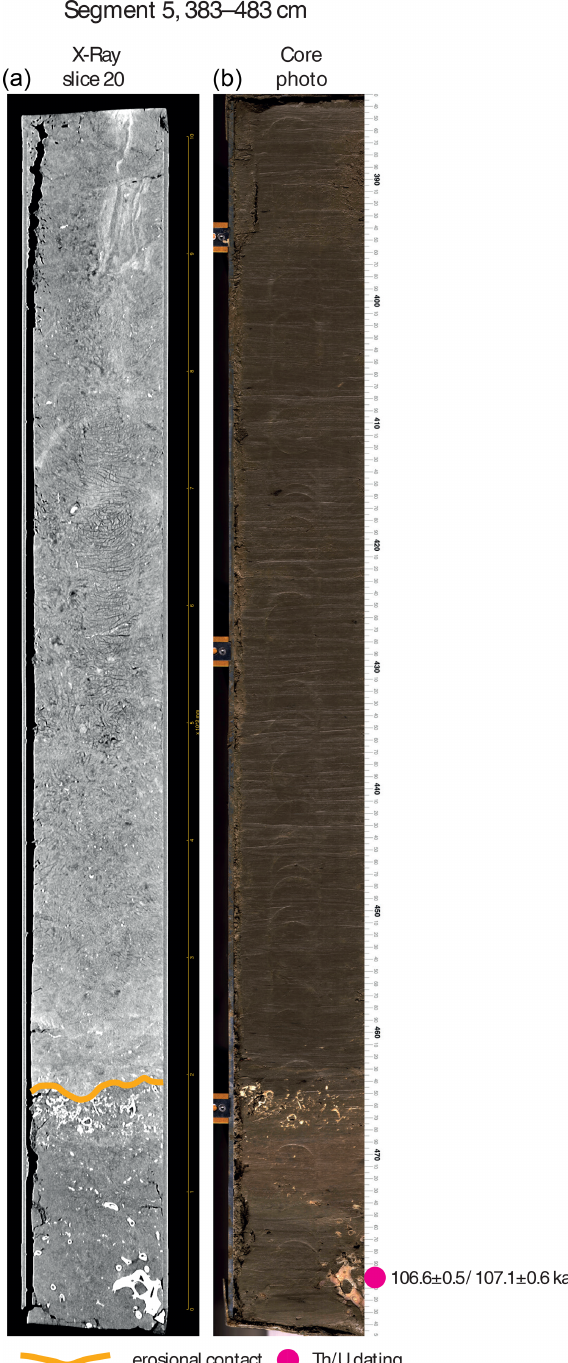
Figure E1. CT image (a) and photography (b) of segment 383–483cm of core M125-34-2. Erosional contacts are marked by thick black lines; position of Th / U dating with calibrated age is indicated by a magenta